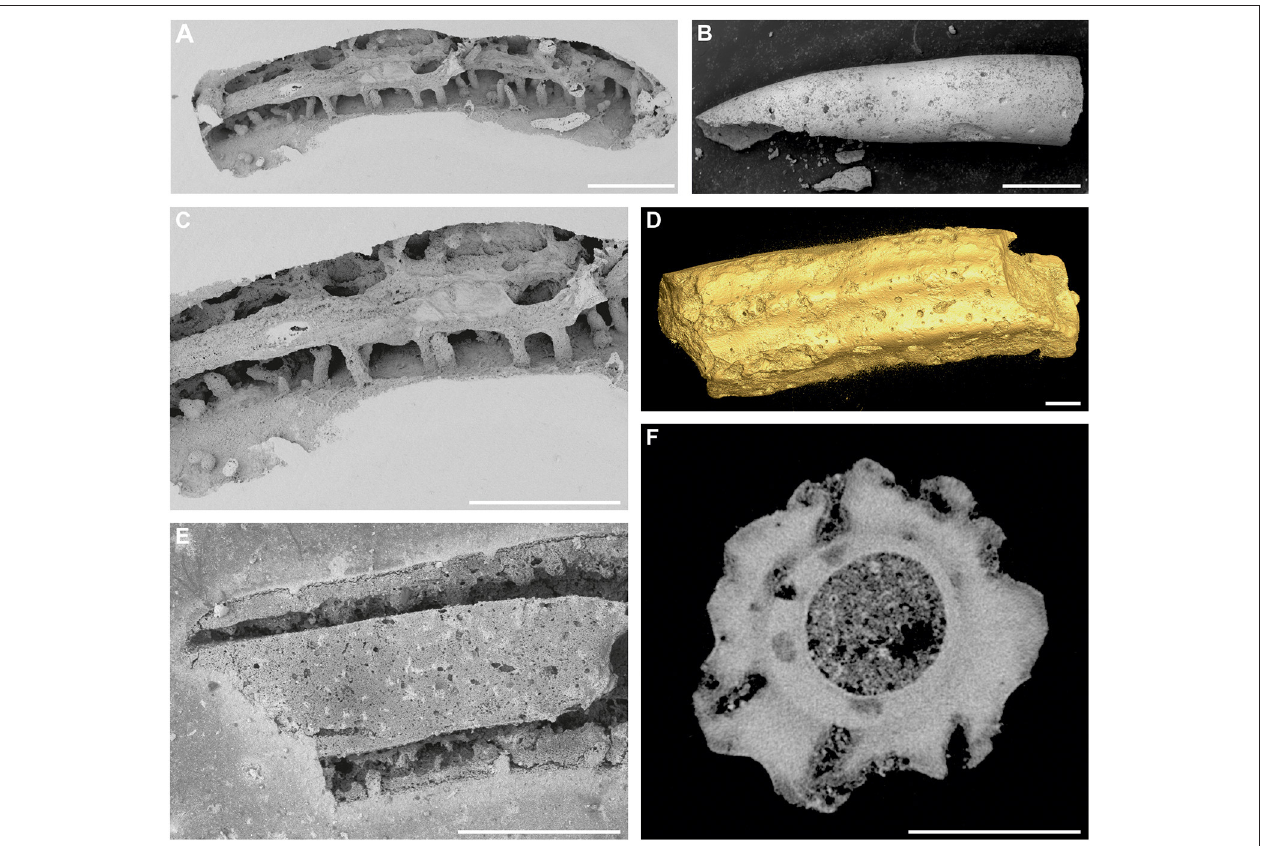
FIGURE 2 | Trypanites isp. in various frequency and spatial distribution. (A,C) Pyrgopolon ( Septenaria ) cf. tricostata ; numerous shafts of Trypanites isp. cut by the longitudinal boring Maeandropolydora isp.; SEM images of casted NM O8728; Kank “Na Vrších,” Bohemian Cretaceous Basin, Czechia. (B) Widely-spaced openings of Trypanites isp. on the outer surface of the inner tube of Pyrgopolon ( Pyrgopolon ) deforme ; SEM image of MHNLM EMV 2016.3.88; Le Mans, France. (D) More densely crowded openings of Trypanites isp. on the outer tube of Pyrgopolon ( Pyrgopolon ) deforme ; Micro-CT isosurface visualization of MHNLM EMV 2016.3.22; Le Mans, France. (E) SEM image of casted, partly dissolved silicified tube of Placostegus zbyslavus , with relatively frequent shallow shafts of Trypanites isp. NM O8727; Kamajka, Bohemian Cretaceous Basin, Czechia. (F) Numerous shafts of Trypanites isp. found in Pyrgopolon ( Pyrgopolon ) deforme on a computed tomography cross-section of the serpulid tube (note their preferred position on the longitudinal ribs) and smaller circular sections which probably represent the galleries and exploratory threads of the ichnogenus Entobia . MNHLM EMV 2016.3.44; Le Mans, France. Scale bars =